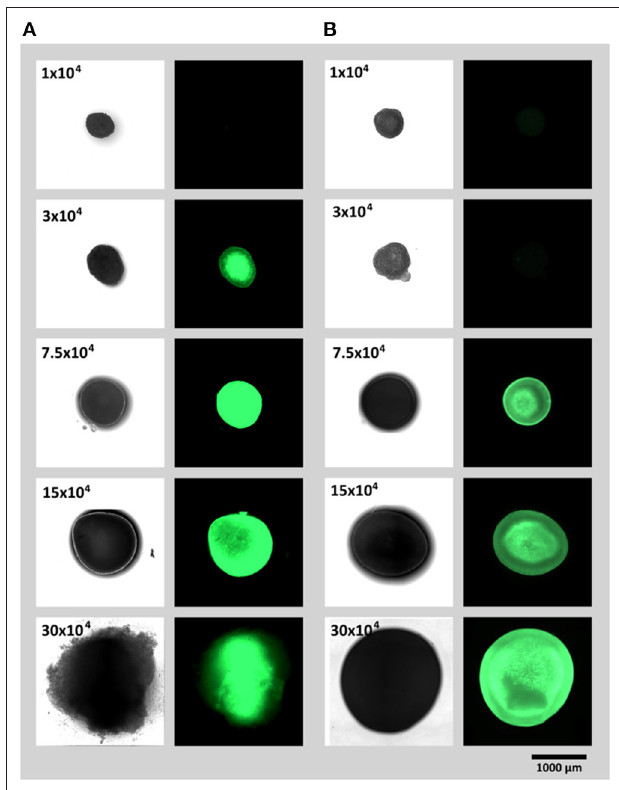
FIGURE 2 | Spheroid formation and resulting reporter hAD-MCSs fluorescence (UnaG expression) after 24h on (A) ultra low attachment plates and (B) via hanging drop